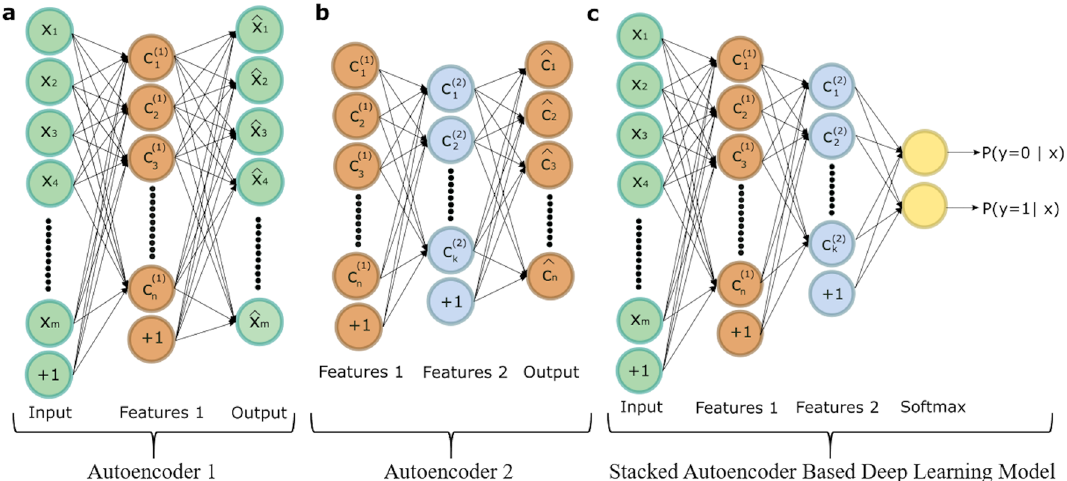
Figure 2. The structure of the proposed deep learning model. ( a ) First autoencoder that reveals the features from the input data. ( b ) Second autoencoder that reveal the new features from the first autoencoder’s hidden layer. ( c ) The deep learning model that is formed stacking the two autoencoders and softmax hidden layer to the second autoencoder’s hidden layer with 15 neurons as depicted in Fig. 2b, (c) the encoder parts of the trained autoencoders and softmax layer are consecutively connected to construct an SAE-based deep learning model, as seen in Fig. 2c, and (d) finally, to achieve fine-tuning the backpropagation algorithm is performed, and weights are updated with labeled training data. One of the main challenges in DNN models is hyperparameter optimization. It is a difficult and time-con- suming process. The amount of data needed in such models should be much larger than the number of hyper- parameters in the network. Otherwise, over-fitting an undesirable situation occurs. In such a scenario, while the network produces very successful results on the training set, it cannot generalize the model on the unseen test set. Therefore, hyperparameter optimization and the number of samples in the dataset is critically important. The hyperparameter optimization was done by random search. The specific parameters used to construct SAE-